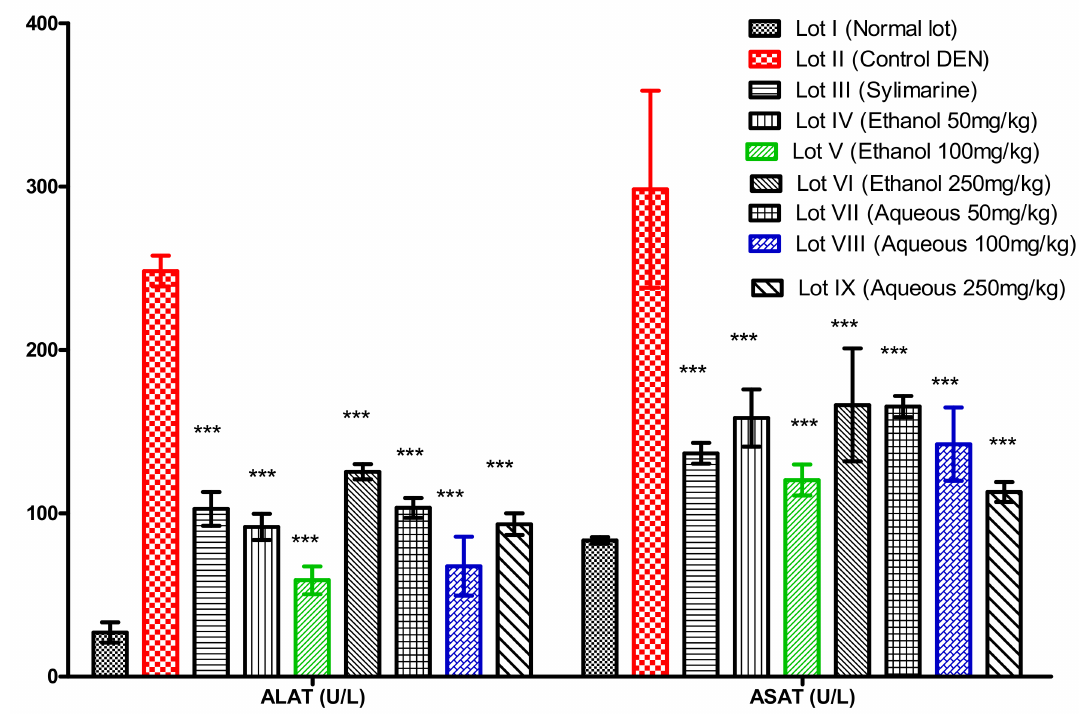
Figure 2. Assay results of alanine aminotransferase (ALAT) and aspartate aminotransferase (ASAT); p < 0.001: the difference is very highly significant ***. Compared with the positive control